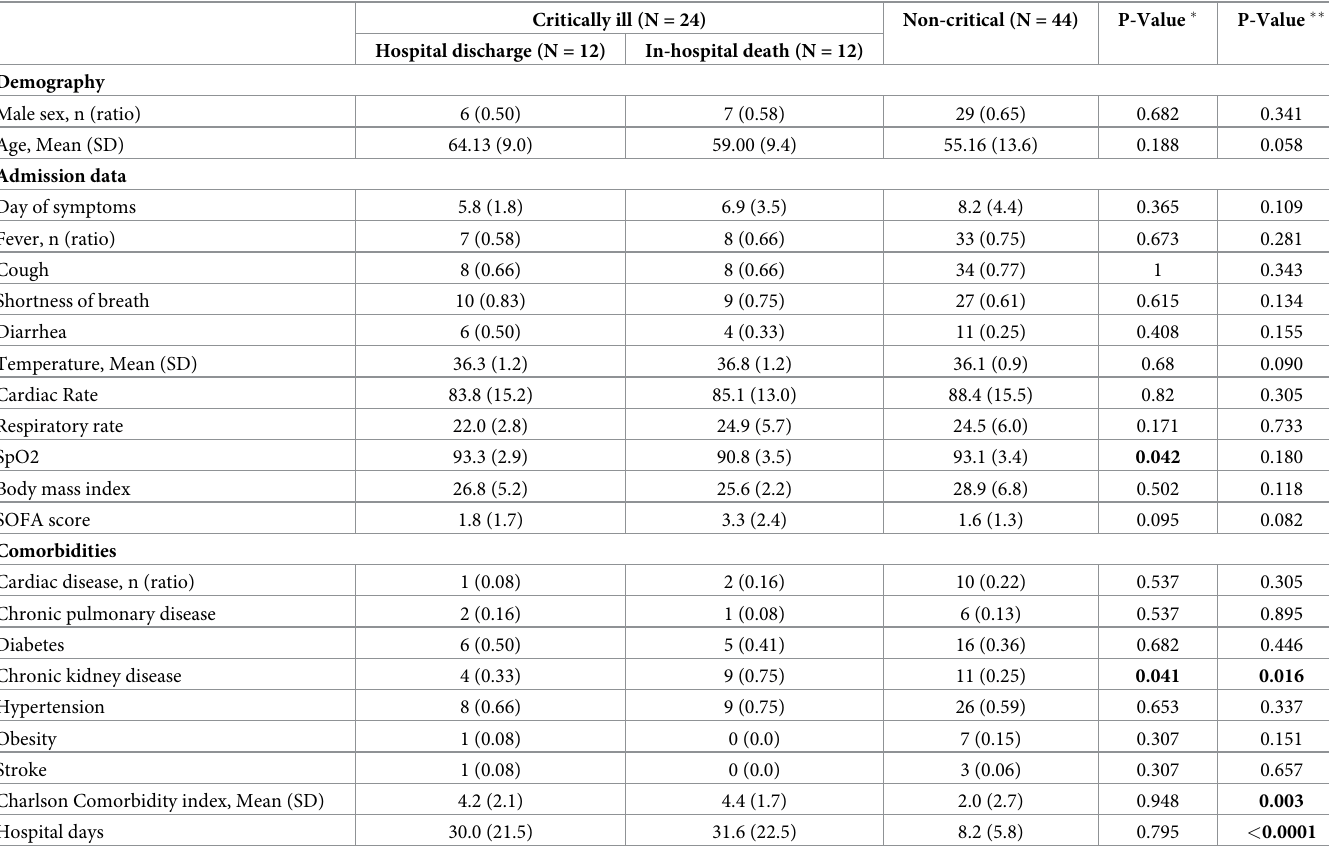
Table 1. Epidemiologic and clinical characteristics of the cohort accordingly to the clinical course and outcomes of the